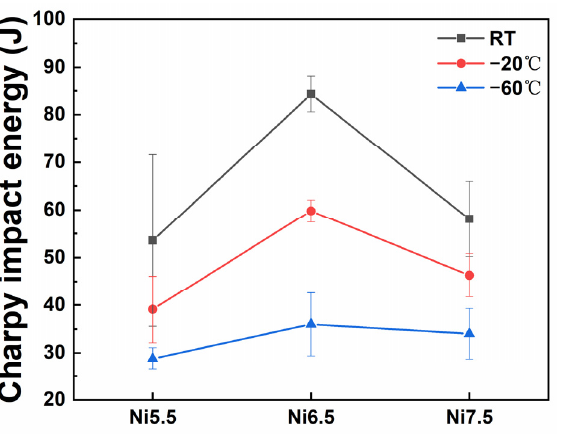
Figure 12. Variation in the impact energy of the deposited metals as a function of Ni contents at RT, − 20 °C, and − 60 °C.